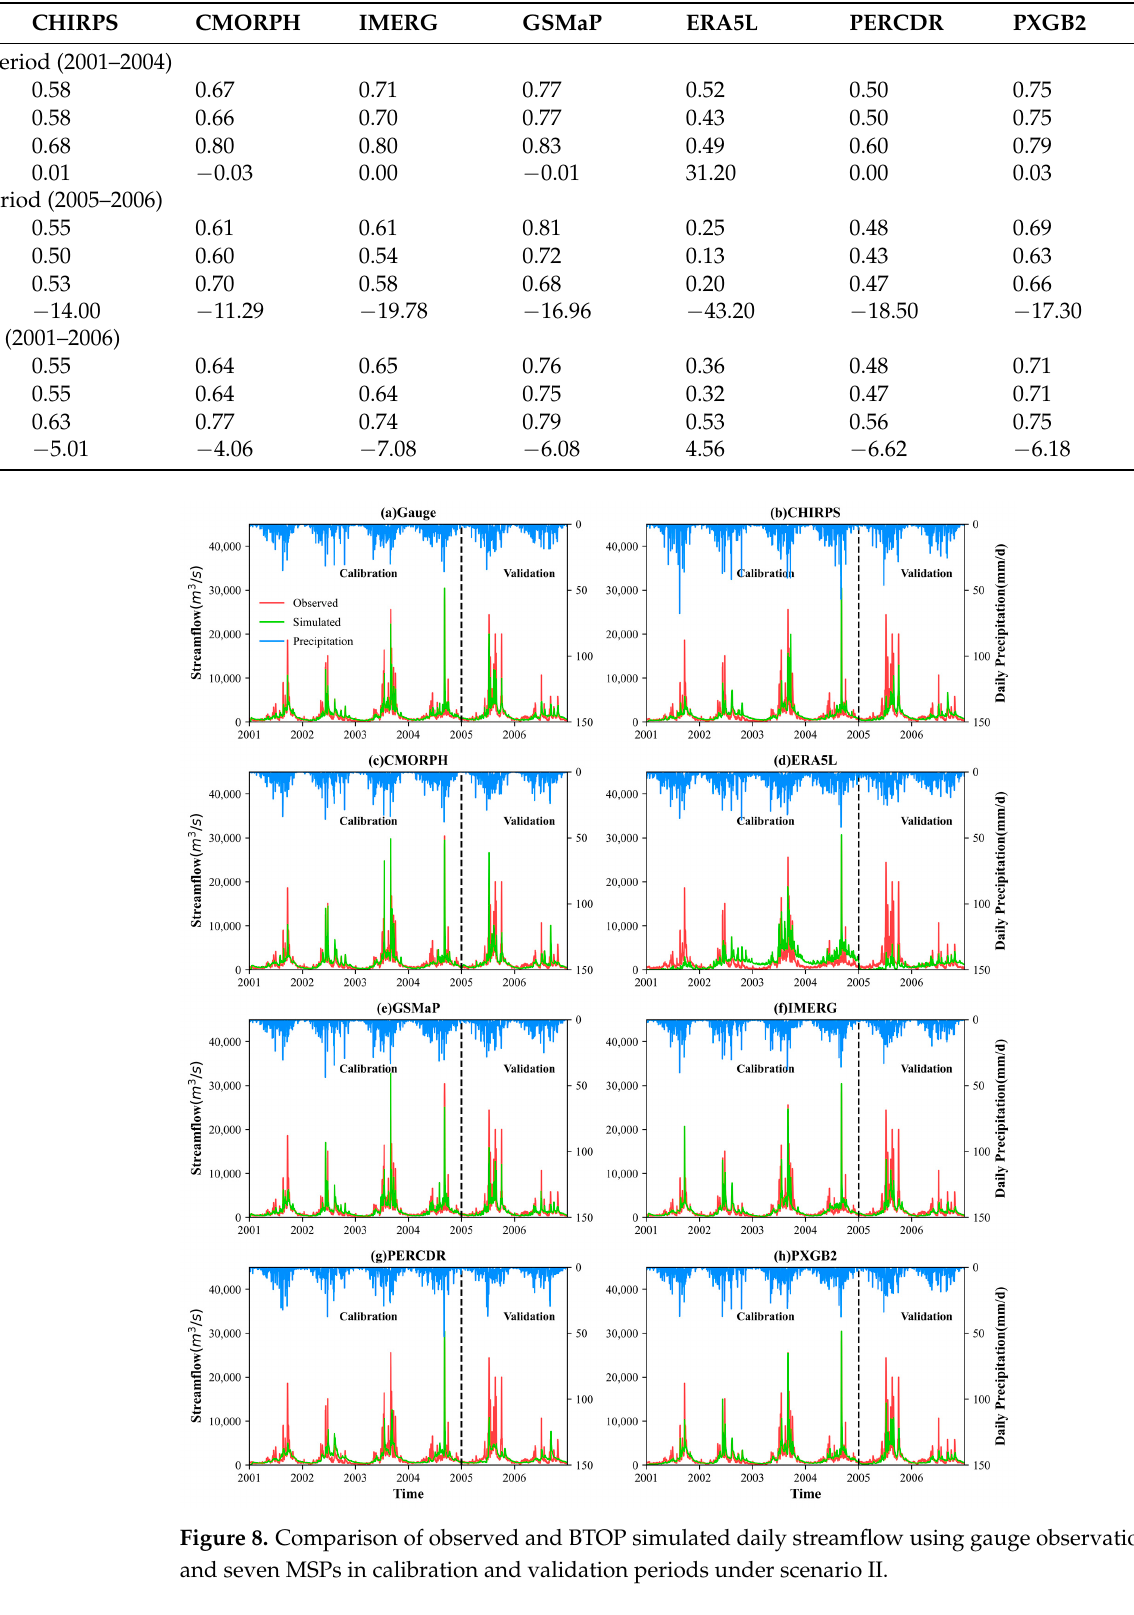
Table 7. Performance of daily streamflow simulations of seven MSPs under scenario II.